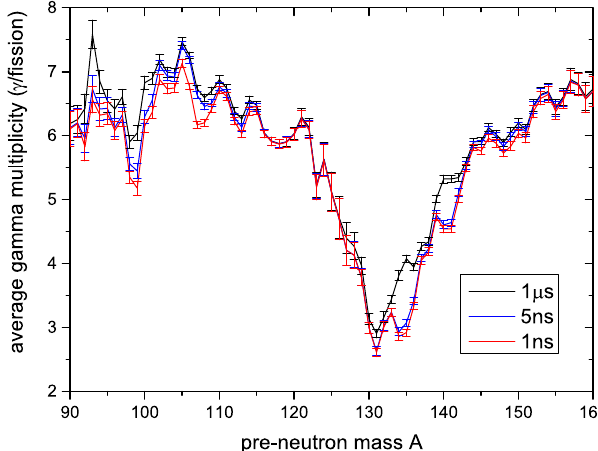
Fig. 3. In fl uence of the half-life of levels on the prompt fi ssion gamma spectrum between 500 and 700 keV. Table 1. S n differences from RIPL3-2009 to RIPL3-2015.